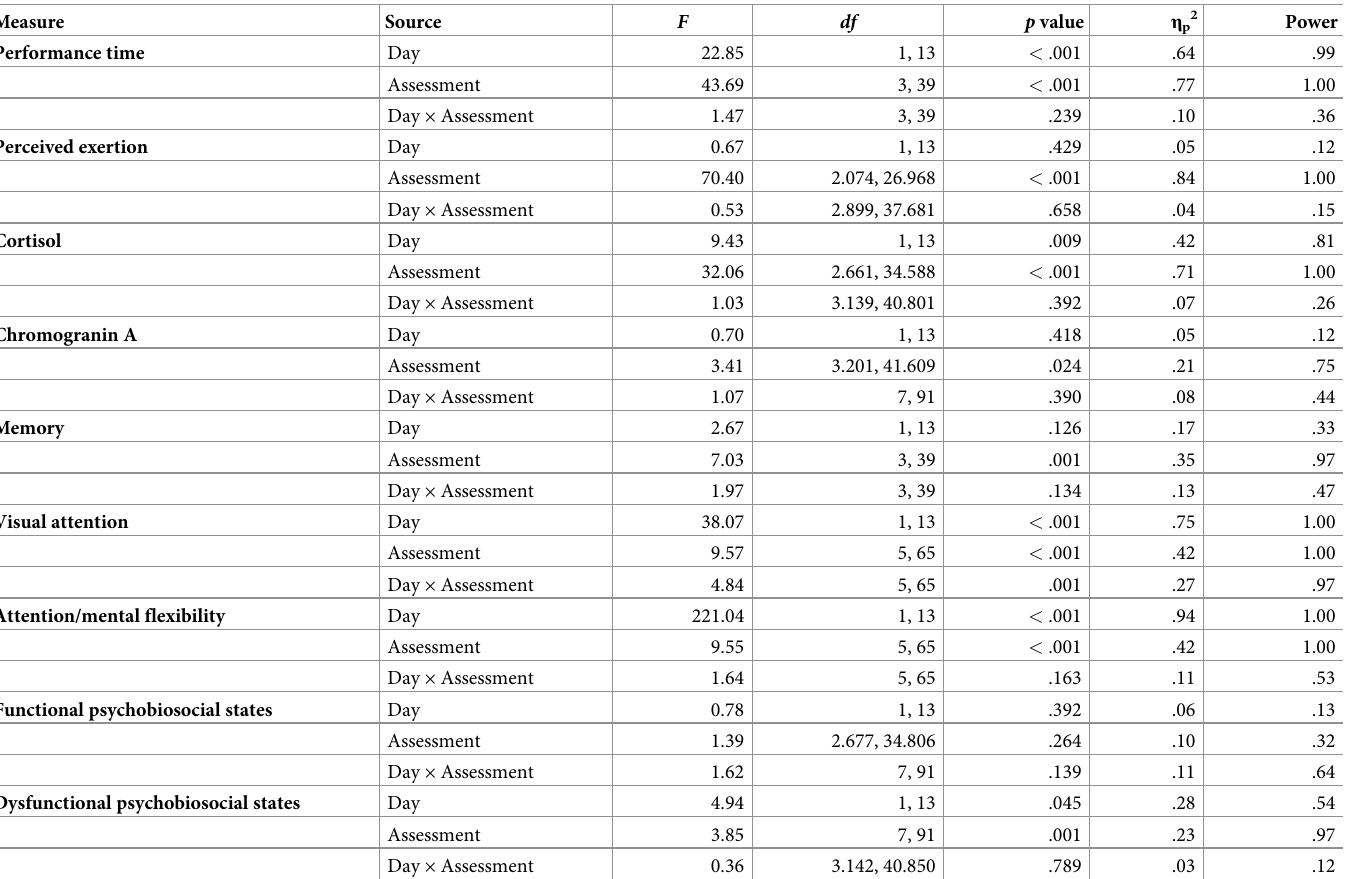
Table 2. Analysis of variance